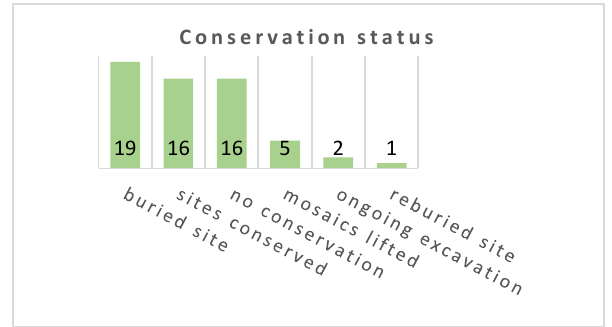
fig. 2. Conservation status distribution.